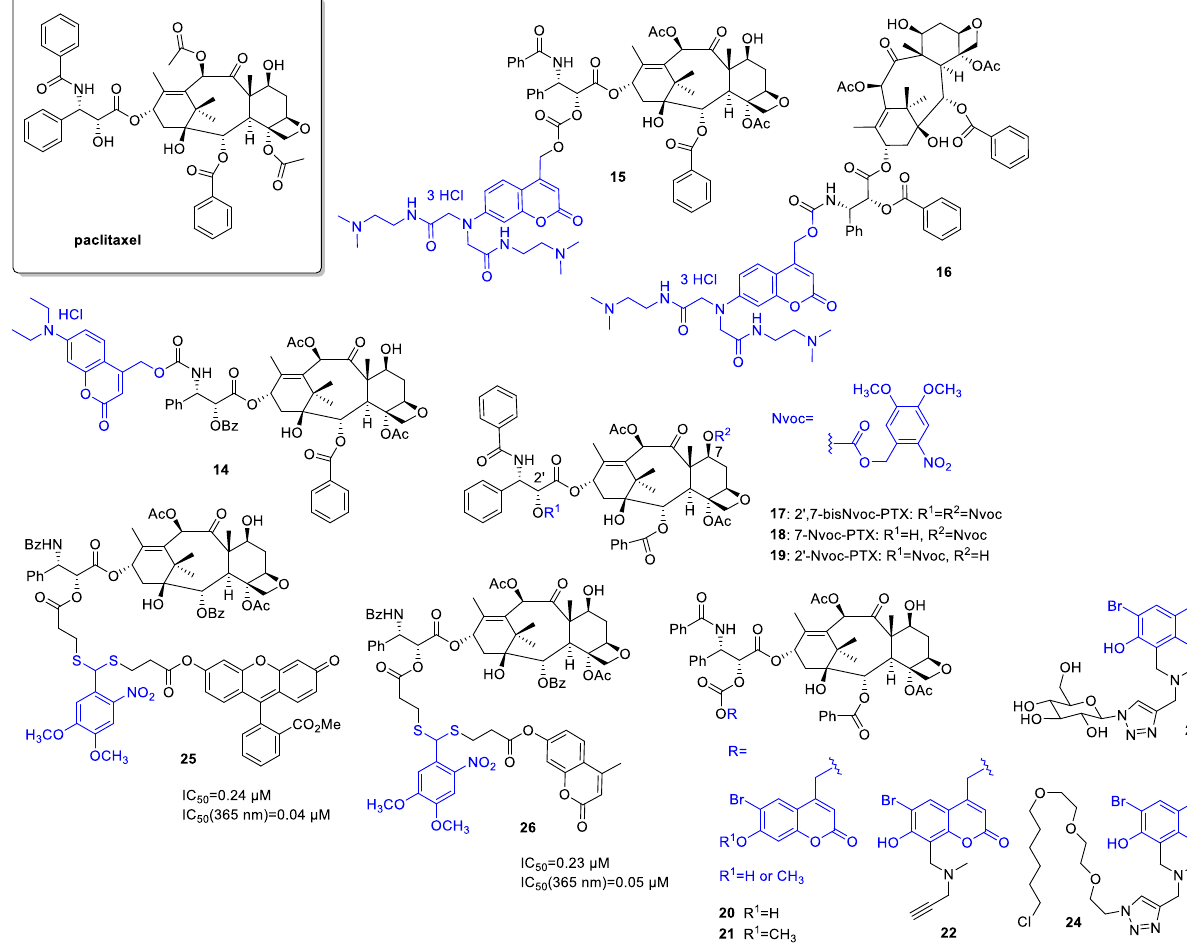
Figure 5. Photocaged paclitaxel derivatives, the PPG indicated in blue.